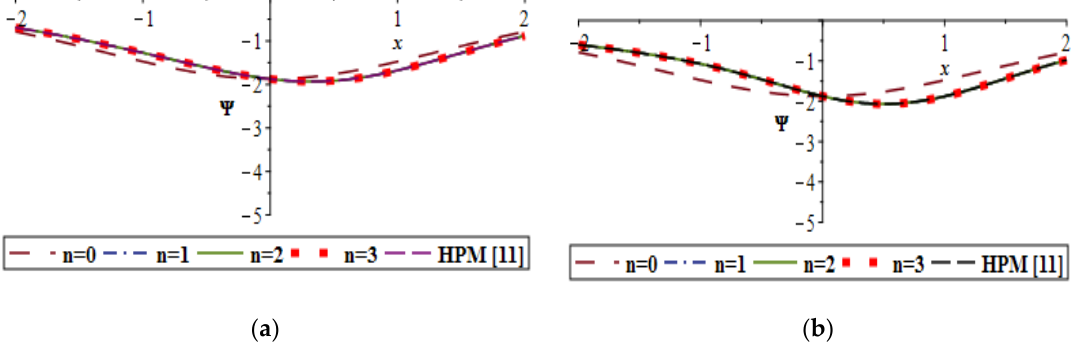
Figure 8. Comparison plots of